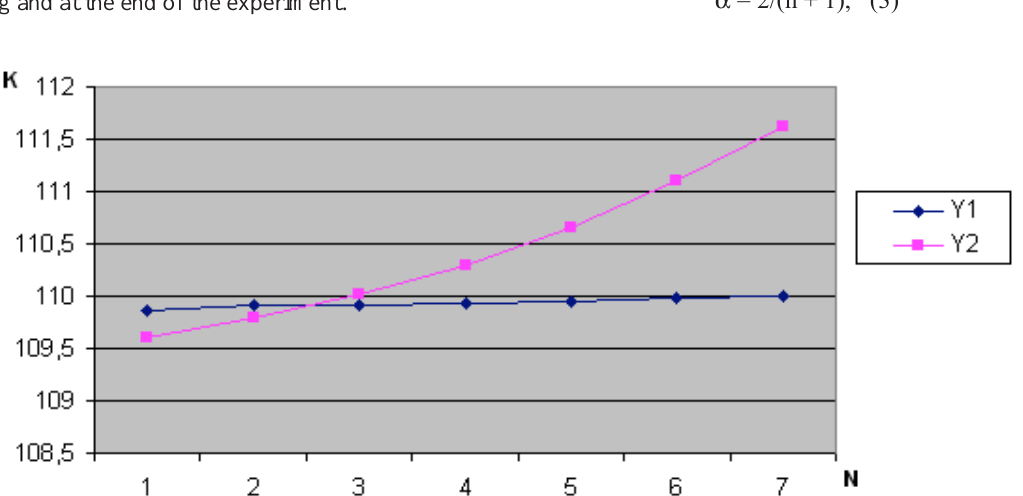
Fig. 3. Comparison of data of control (Y